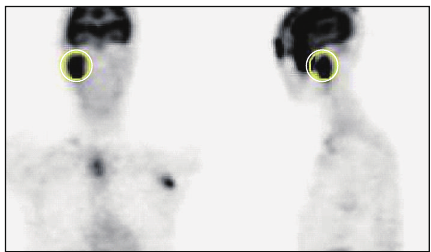
Figure2: Positronemissiontomographic imageforCase 1,showing hypermetabolic activity in the right parotid gland (circles), right eyelid, and anterior mediastinal lymph nodes.